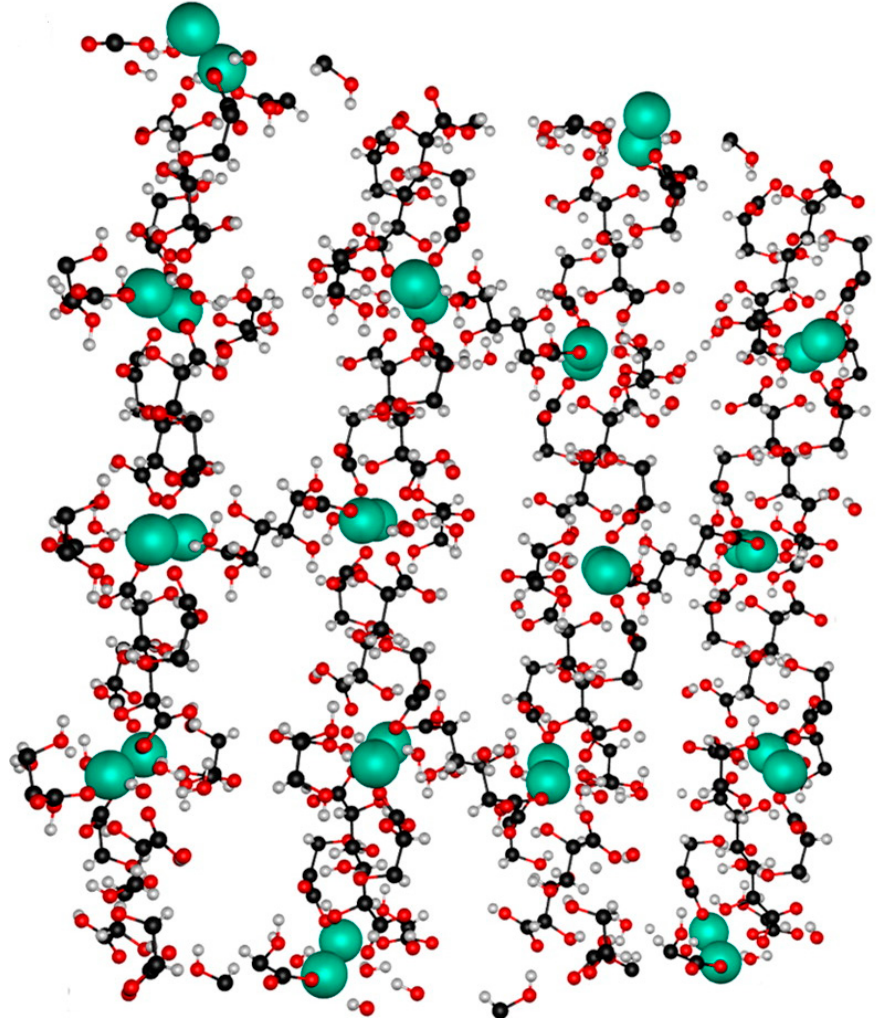
Figure 5. Crystal structure of the neutral metal–organic framework (MOF) (Tb(galactarate) 1.5 (H 2 O) 2 ) · 5H 2 O shown in a ball-and-stick representation, with the Tb(III) ions in a space-filling model. Water molecules in the channels have been omitted for clarity, and atoms are color coded as follows: C = black; H = white; O = red; Tb = turquoise [48].